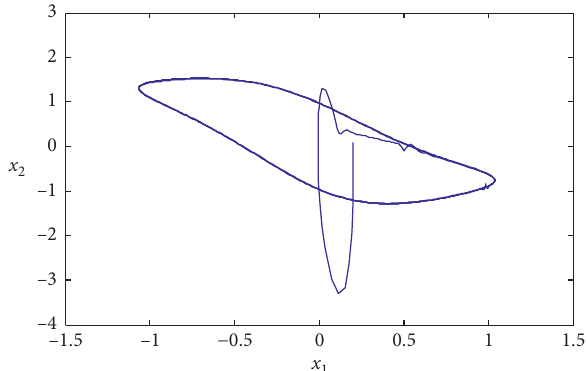
Figure 2: Phase portrait of states x